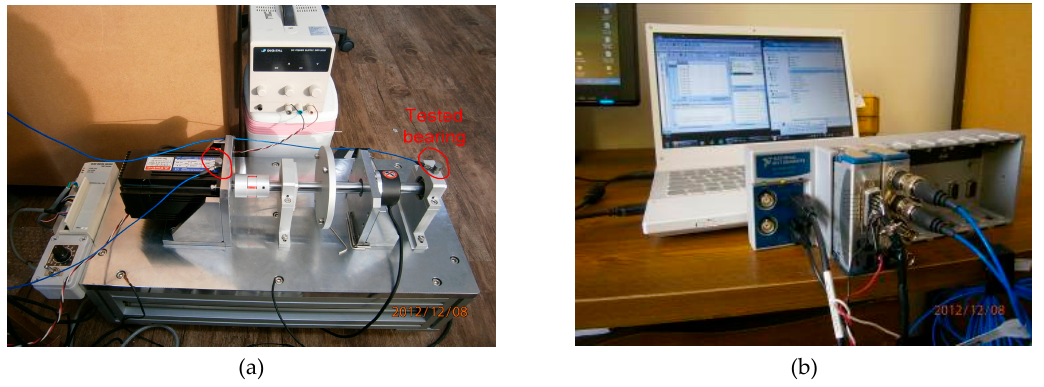
Figure 4. The experimental setup: ( a ) test-bench and ( b ) data-acquisition equipment.